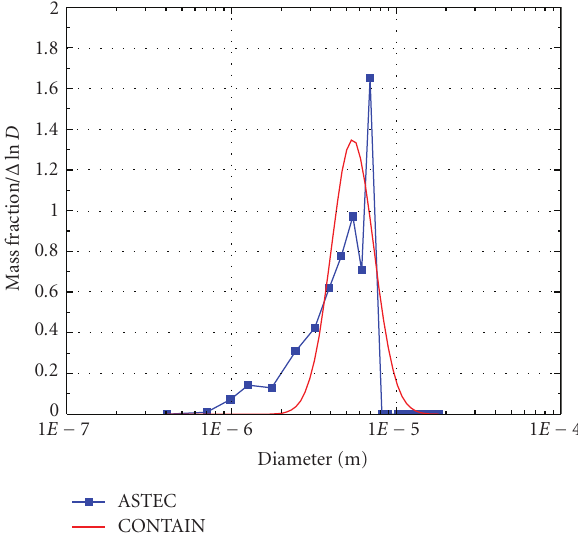
Figure 3: Aerosol size distribution defined in both code simula-